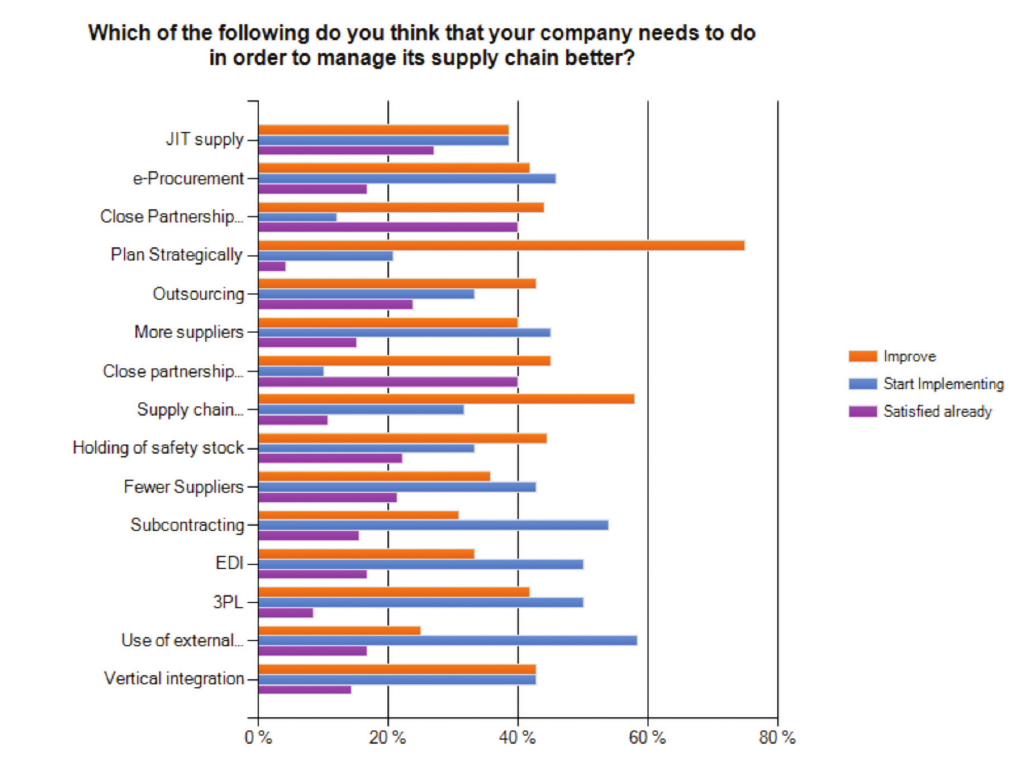
Figure 4: Measures to improve supply chain management